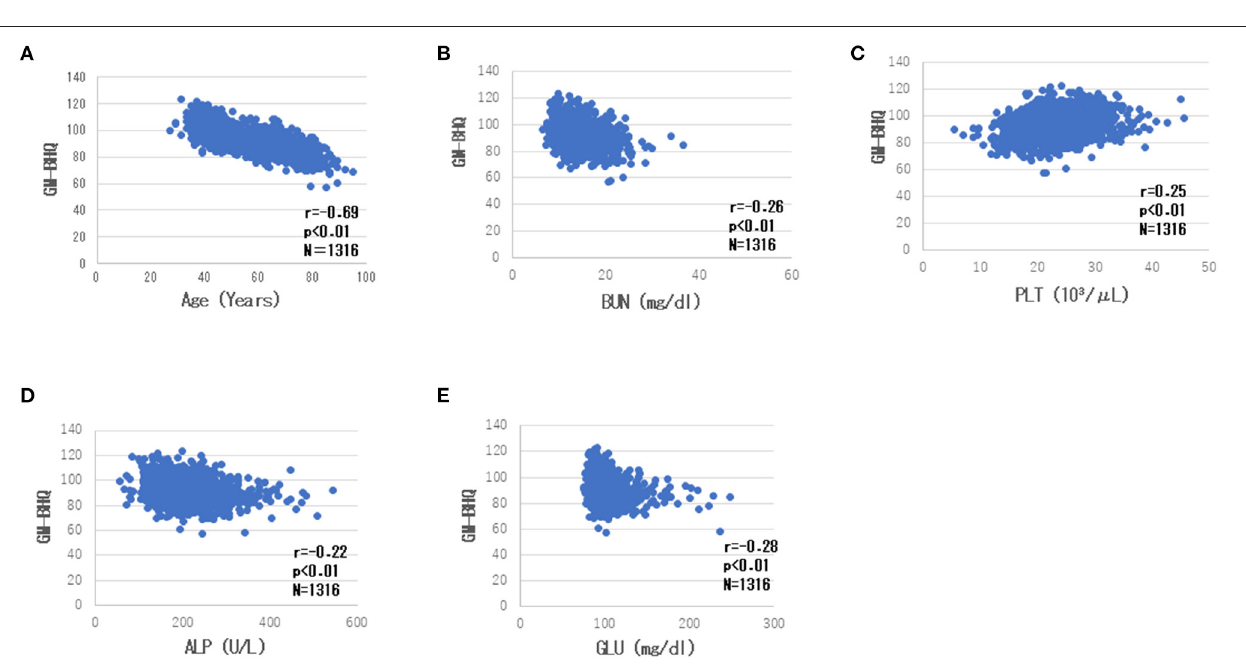
FIGURE 3 | Scatter plots of GM-BHQ, subject age, and blood data. The vertical axis indicates the GM-BHQ, and the horizontal axis indicates subjects age (A) , BUN (B) , PLT (C) , ALP (D) , and GLU (E) , respectively.